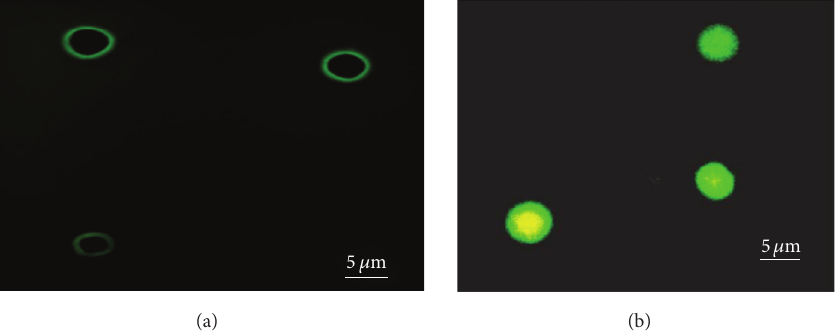
Figure 1: Fluorescence microscopy image of the PEG microspheres stained with Dylight-488 (100x—panel (a)). (a) Represent the PEG microsphere and (b) PEG microspheres with adsorbed glycine. Experiments were repeated five times and the results were